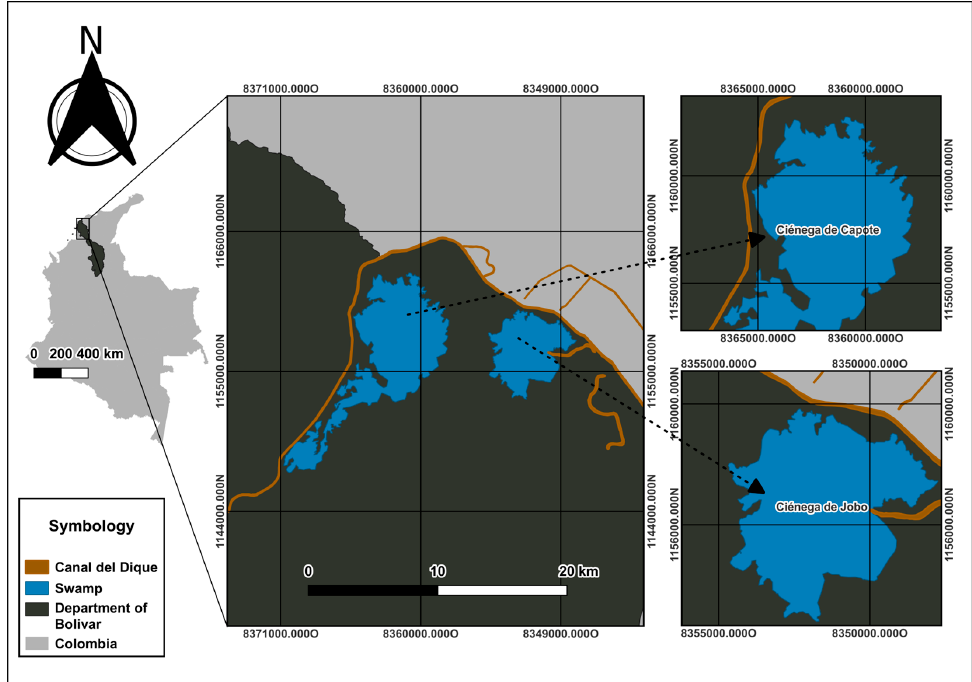
Figure 1. Location of sampling points, UEP1: Ciénaga de Capote (upper right), UEP6: Ciénaga del Jobo (lower right).